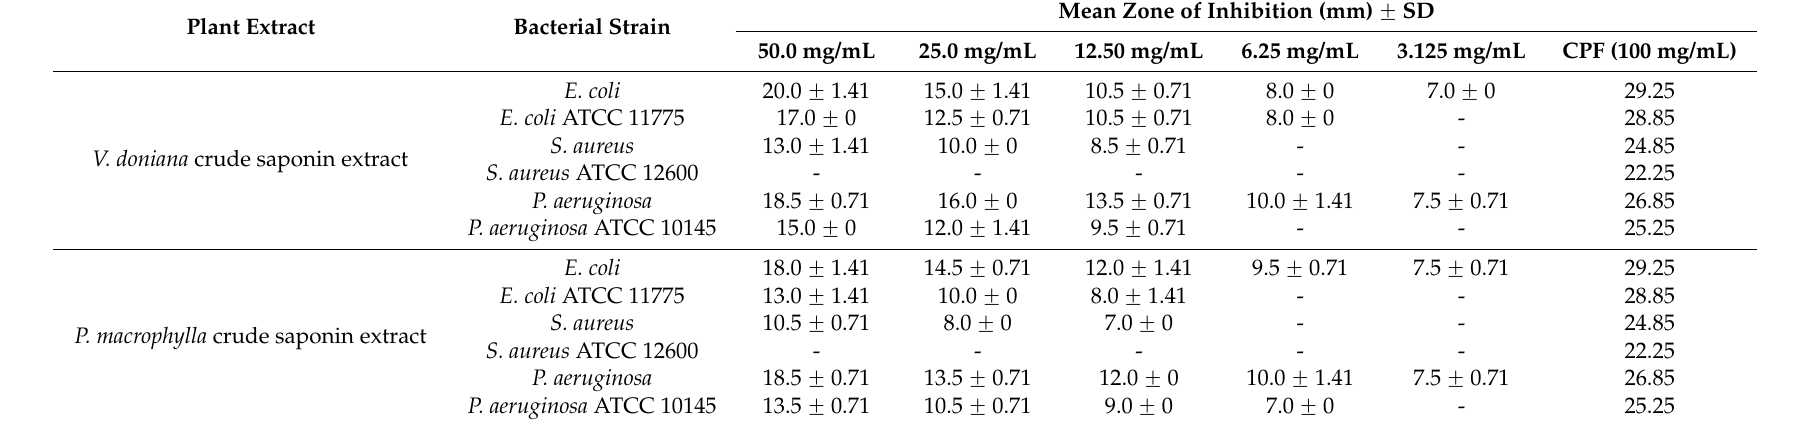
Table 3. Bacteria growth inhibition zones of saponin extract of V. doniana and P. macrophylla stem